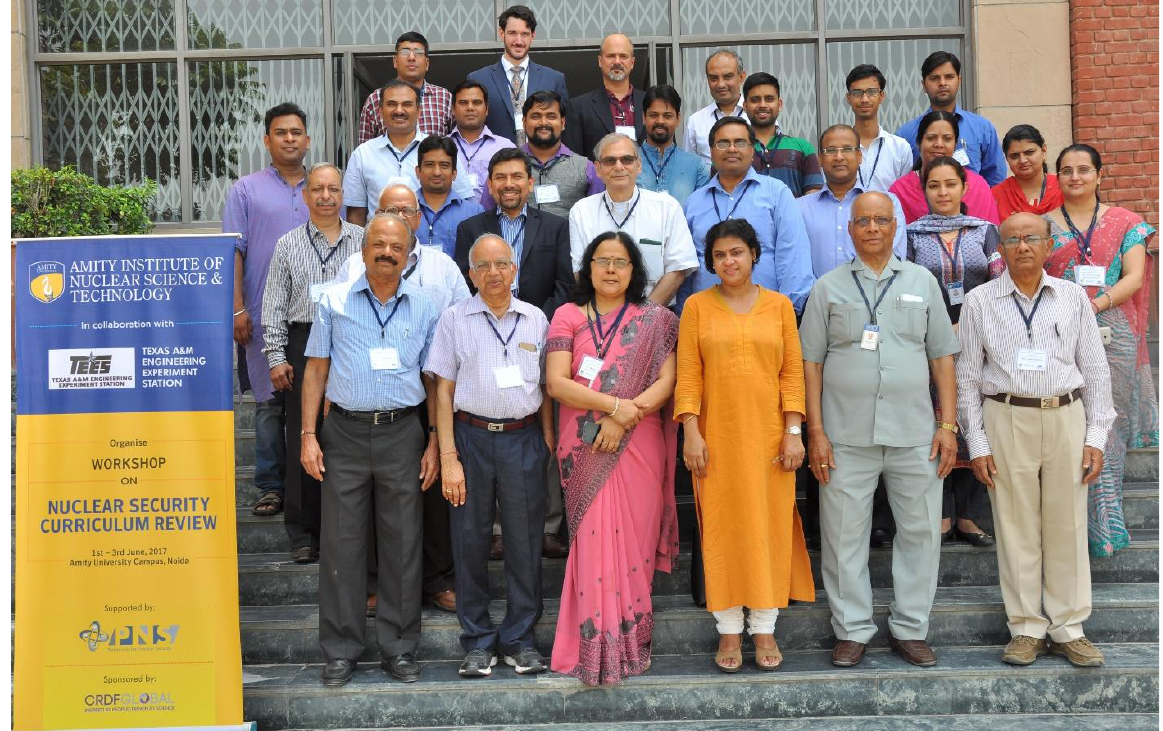
Picture 2. Delegates and participants in the Nuclear Security Curriculum Review workshop, 2017 at Amity